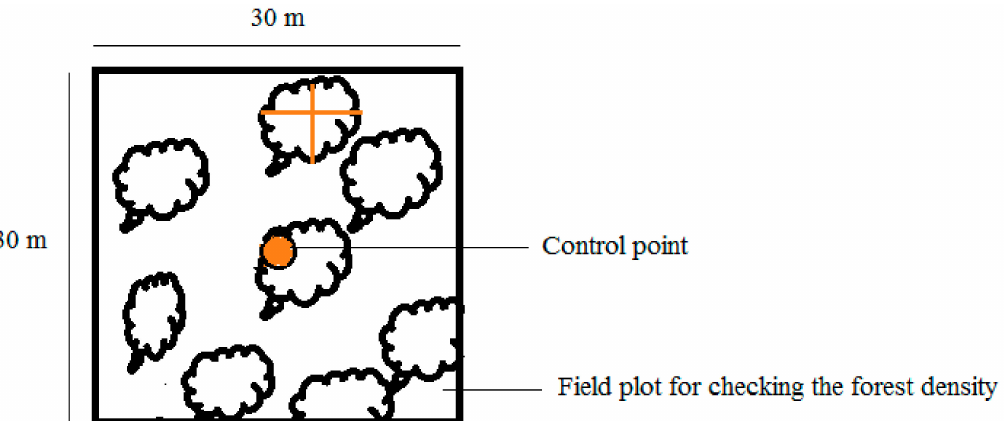
Figure 6. The control point and the field plot for checking the forested land covers (the orange lines show two diameters of each tree in the